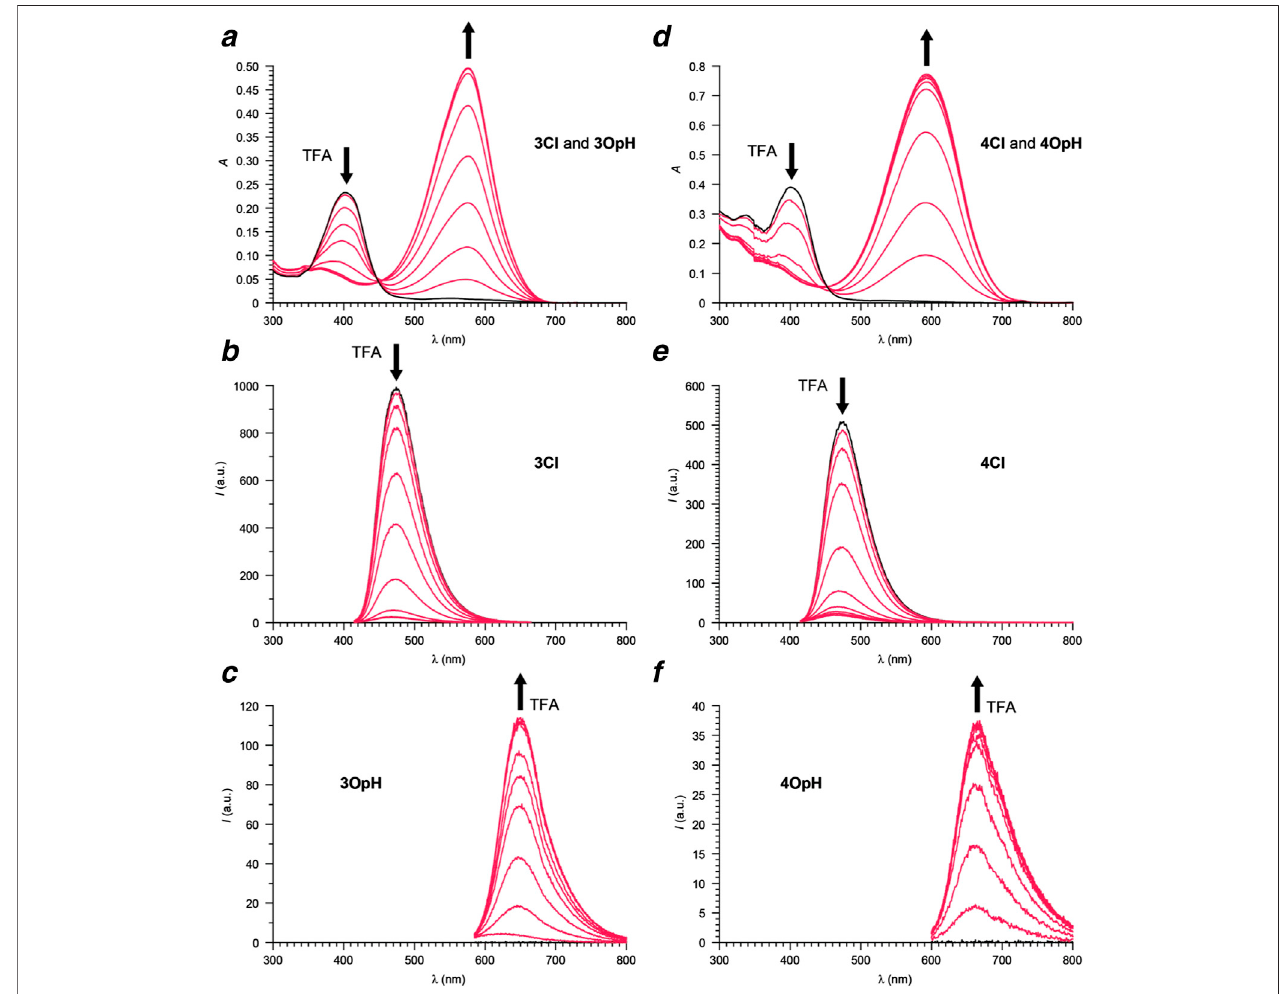
FIGURE 3 | Absorption ( a ) and emission ( b , λ Ex (cid:1) 405 nm; c , λ Ex (cid:1) 575 nm) spectra of a MeCN solution of 3 (6 µM) recorded before (black) and after (red) the addition of increasing amounts of TFA (0.1 – 1.1 eq.). Absorption ( d ) and emission ( e , λ Ex (cid:1) 405 nm; f , λ Ex (cid:1) 575 nm) spectra of a MeCN solution of 4 (11 µM) recorded before (black) and after (red) the addition of increasing amounts of TFA (0.1 – 1.1